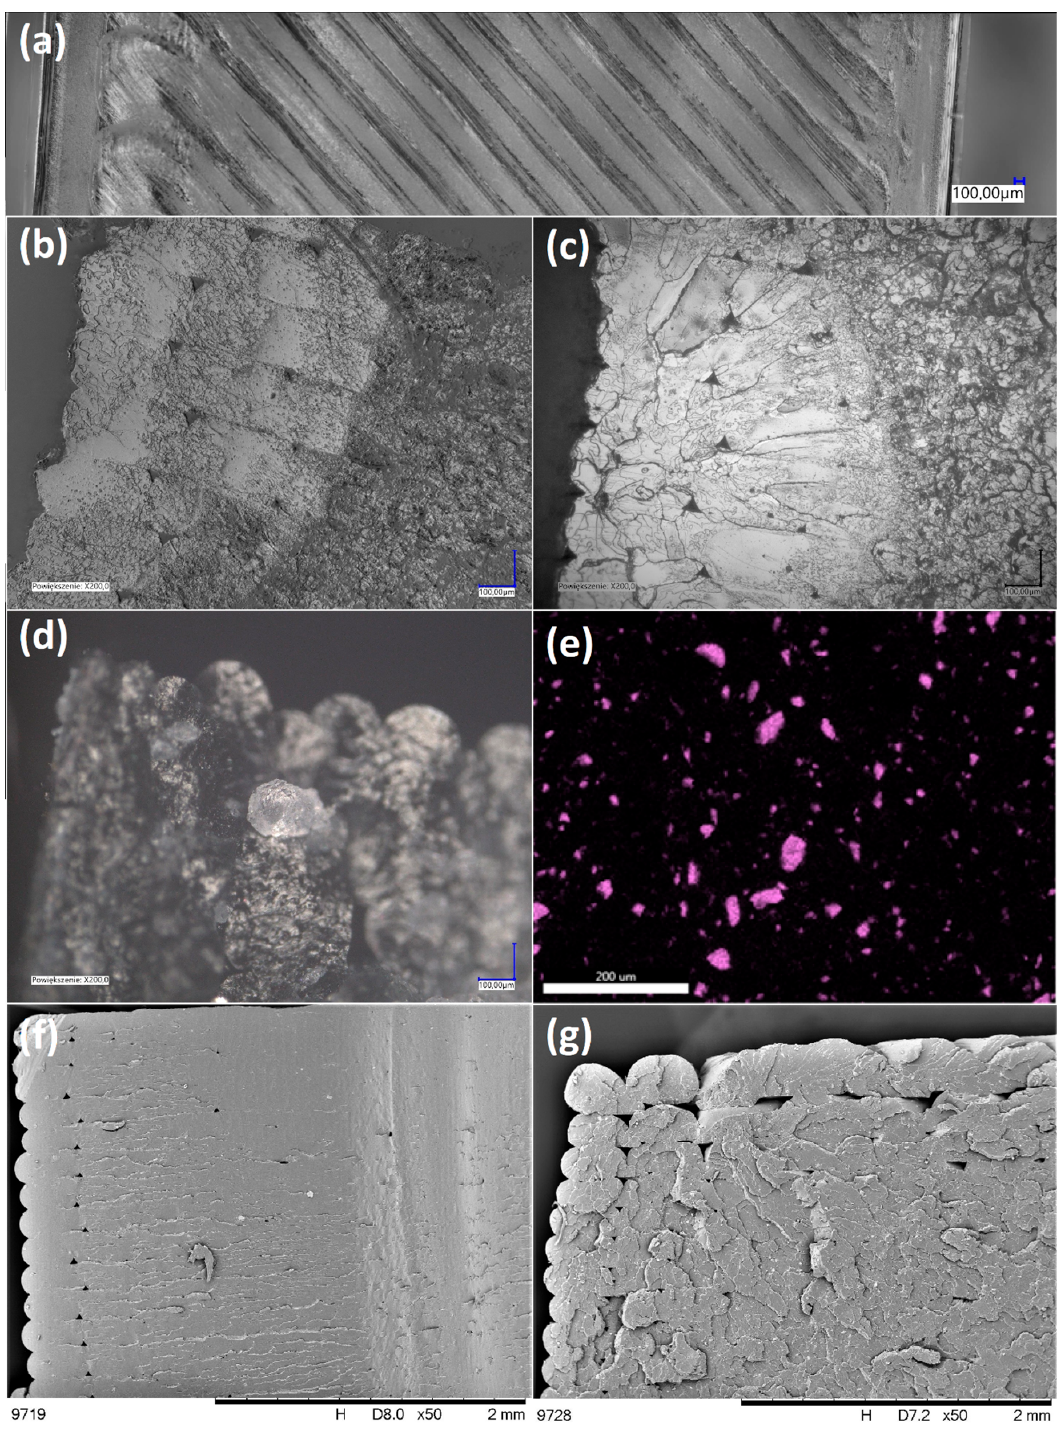
Figure 4. Optical microscopic images ( a – d ) and SEM images ( e – g ) of printed samples: outer surface ( a ), fractured sample from neat PLA ( b ), fractured sample from 0.25% SS-Limonene/PLA ( c ), a crystal of polymerized SS-Limonene ( d ), silicon EDS image of 0.25% SS-Limonene/PLA fractured sample ( e ), fractured sample from 0.25% SS-Limonene/PLA ( f ), fractured sample from 2.5% SS-Limonene/PLA ( g ).